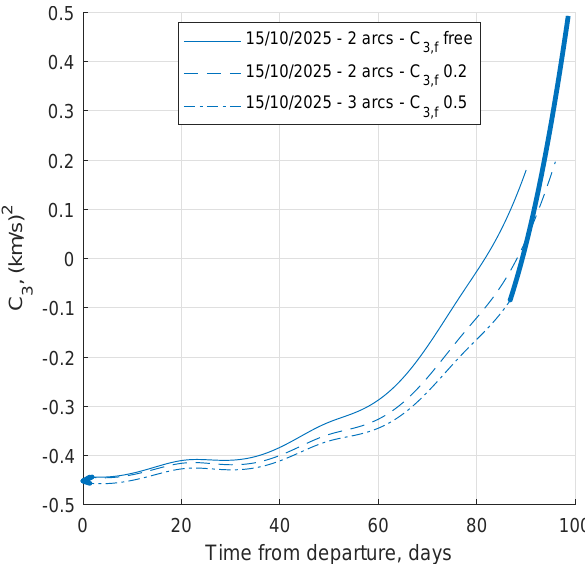
Figure 11. Spacecraft energy over time from SEL2—comparison between free and fixed final C 3